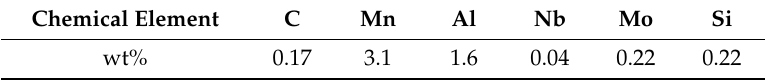
Table 1. Chemical composition of the medium Mn steel used in the